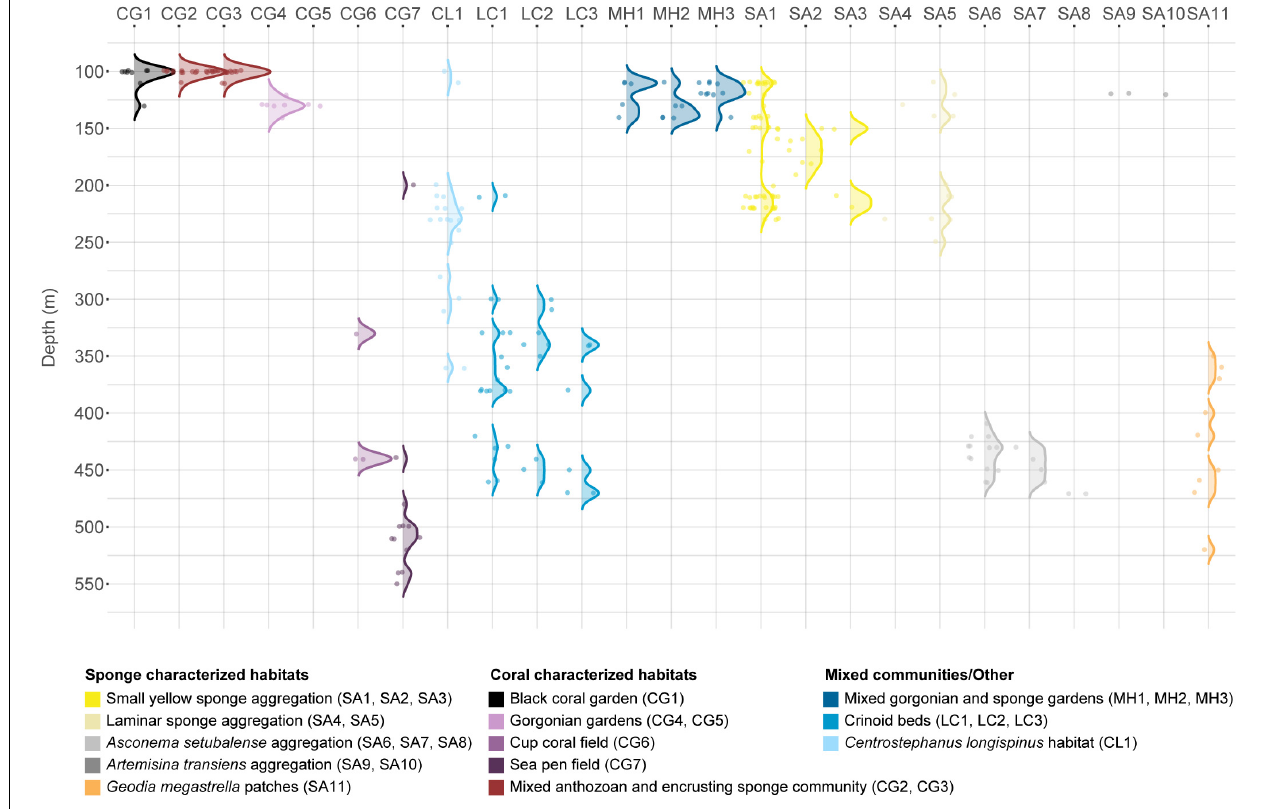
FIGURE 6 | Ridgeline plot of the vertical distribution of assemblages grouped by habitat in the upper S. Vicente submarine canyon (Jittered points represent occurrences). Habitats with two or less data points are represented only by points